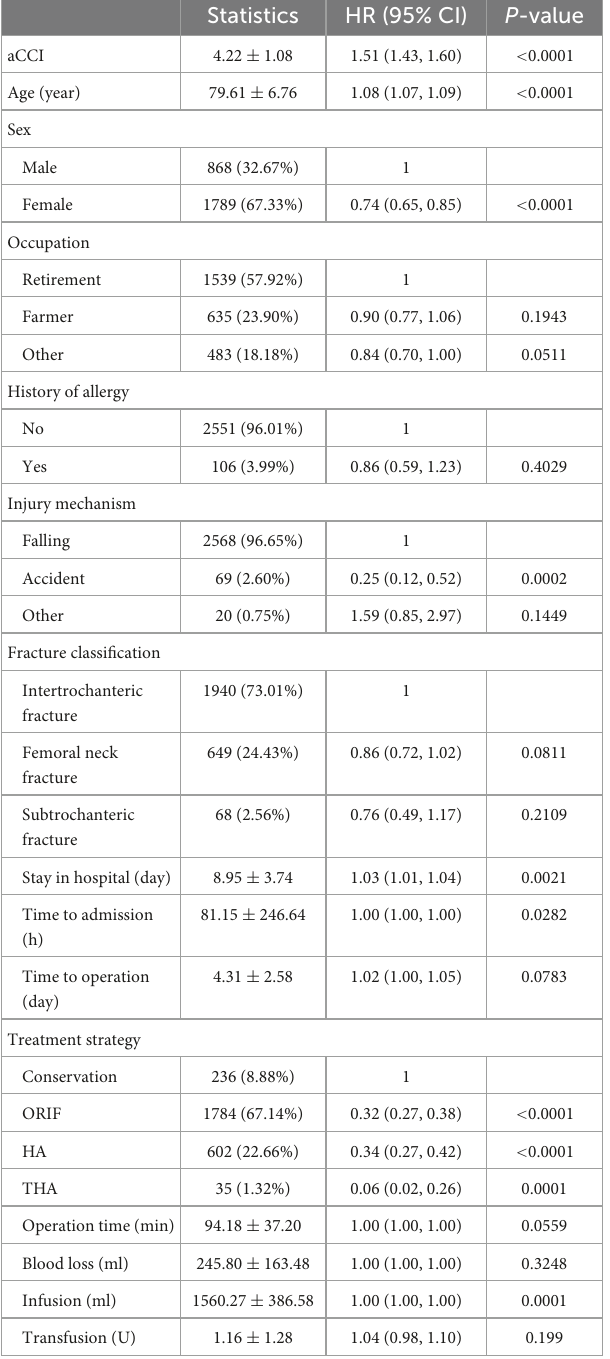
TABLE 2 Effects of risk factors on mortality by univariate